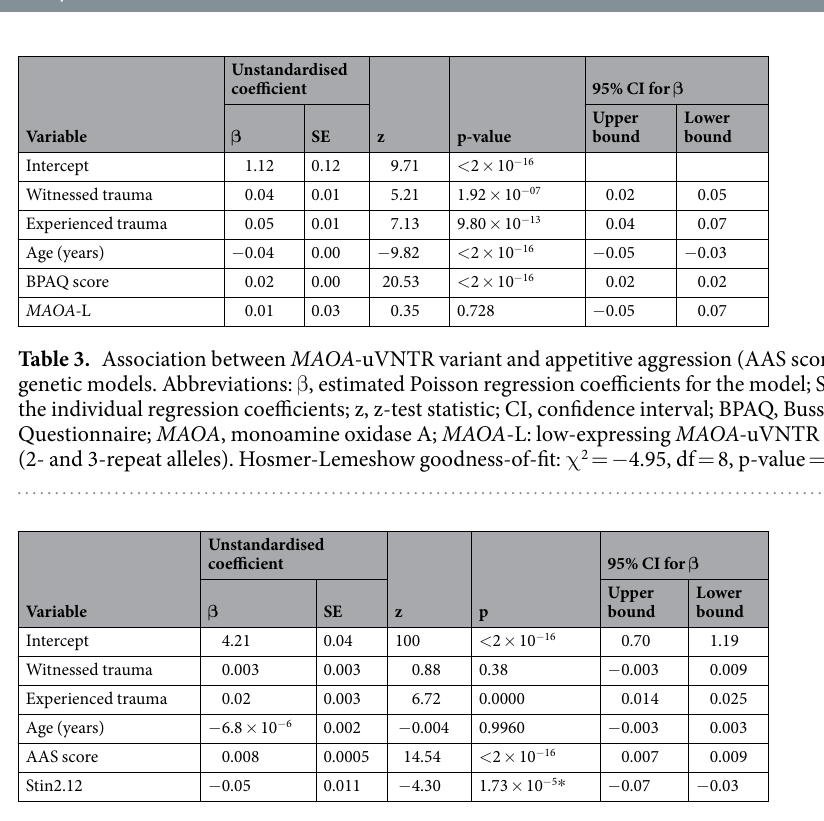
Table 4. Association between STin2 VNTR variant and reactive aggression (BPAQ score), using additive genetic models. Abbreviations: β , estimated Poisson regression coefficients for the model; SE, standard error of the individual regression coefficients; z, z-test statistic; CI, confidence interval; BPAQ, Buss-Perry Aggression Questionnaire; BPAQ, Buss-Perry Aggression Questionnaire; STin2.12, 12-repeat allele of the serotonin transporter intron 2 variant. Hosmer-Lemeshow goodness-of-fit: χ 2 = − 207.95, df = 8, p-value = 1. * Benjamini-Hochberg corrected p-value = 7 × 10 − 5